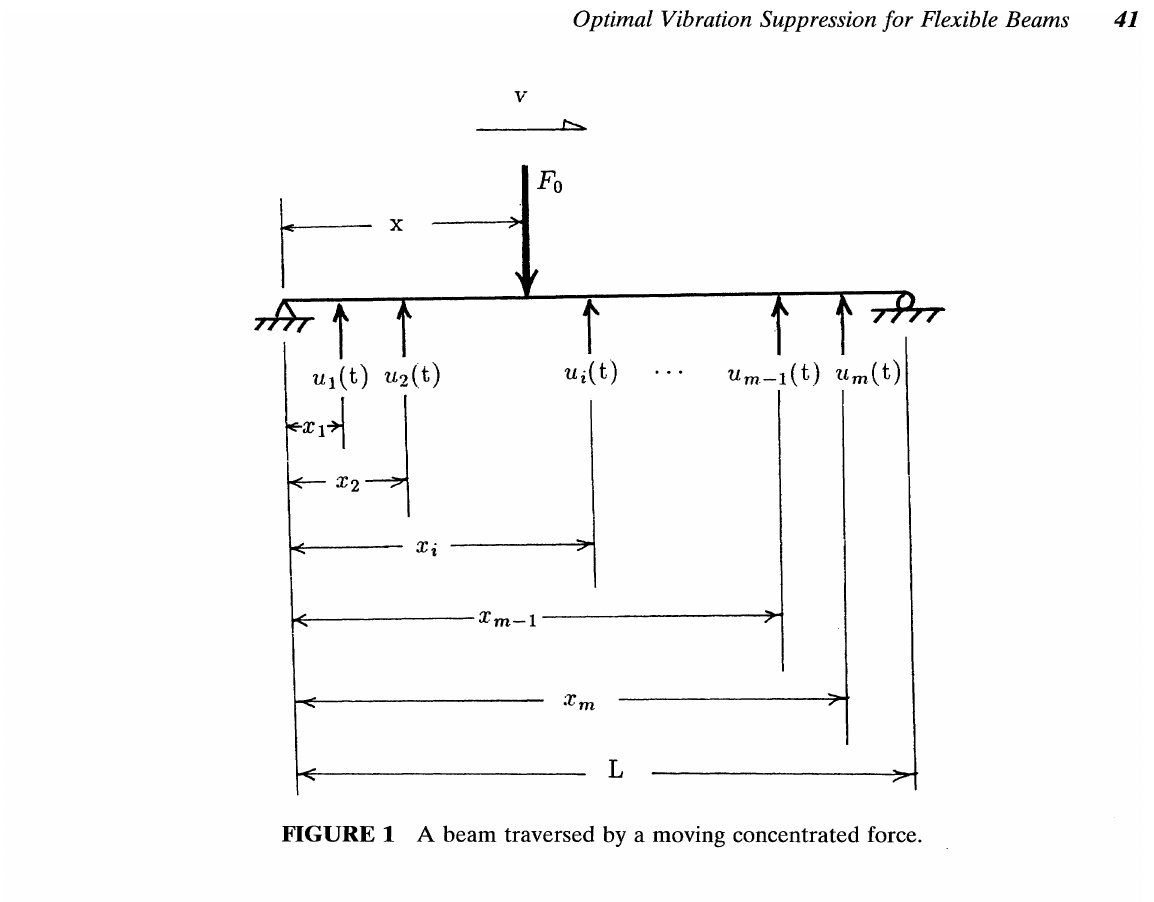
FIGURE 1 A beam traversed by a moving concentrated